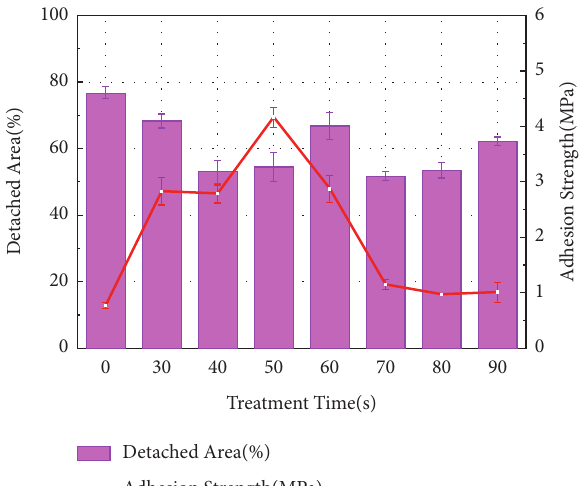
Figure 9: Average values of adhesive strength against the detached area for epoxy-coated aluminum samples with different Ti/Zr/V conversion treatment times